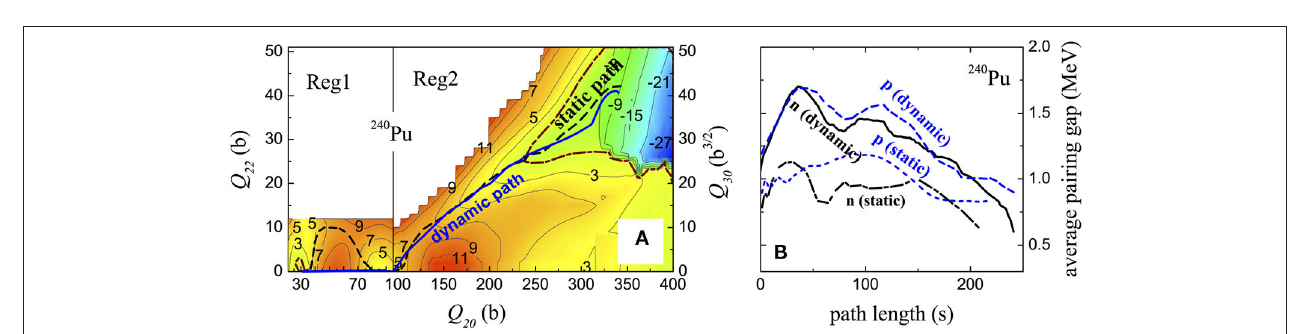
FIGURE 8 | (A) The 3D dynamic path (solid line), projected on the λ 2 0 surface, and the 2D static path (dashed line) in the two considered regions (Reg1: = ( Q 20 , Q 22 , λ 2 ), Reg2: ( Q 20 , Q 30 , λ 2 )) of the collective space. The reason for this choice of 3D-3D configuration space is explained in Sadhukhan et al. [29]. The contours of inner and outer turning points are shown by dash-dotted lines. (B) Average pairing gaps, for neutrons ( n ) and protons ( p ), along the 3D dynamic (with